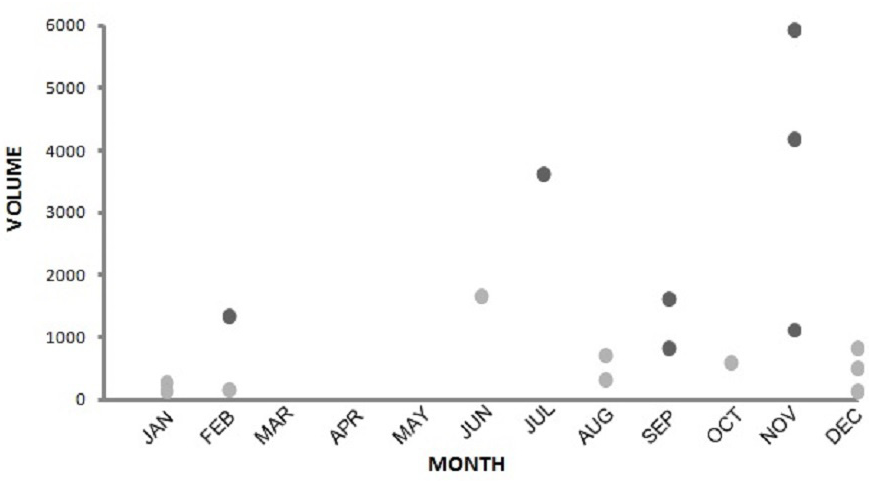
Figure 2 - Size distribution (volume, in mm 3 ) of mature follicles (light gray dots) and oviductal eggs (dark gray dots) of Erythrolamprus miliaris from the state of Rio de Janeiro throughout the